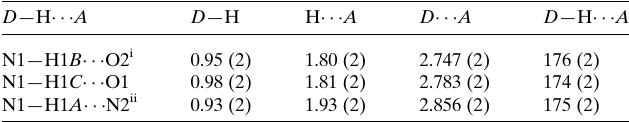
Table 2 Hydrogen-bond geometry (A˚ , (cid:5) ) for (II).